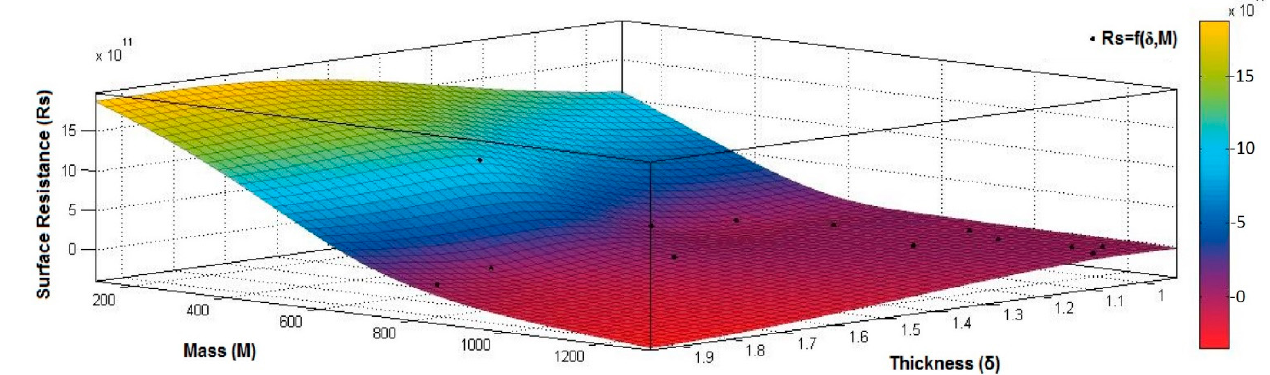
Figure 12. 3D representation Rs = f( M , δ ) samples coated with conductive polymeric paste.